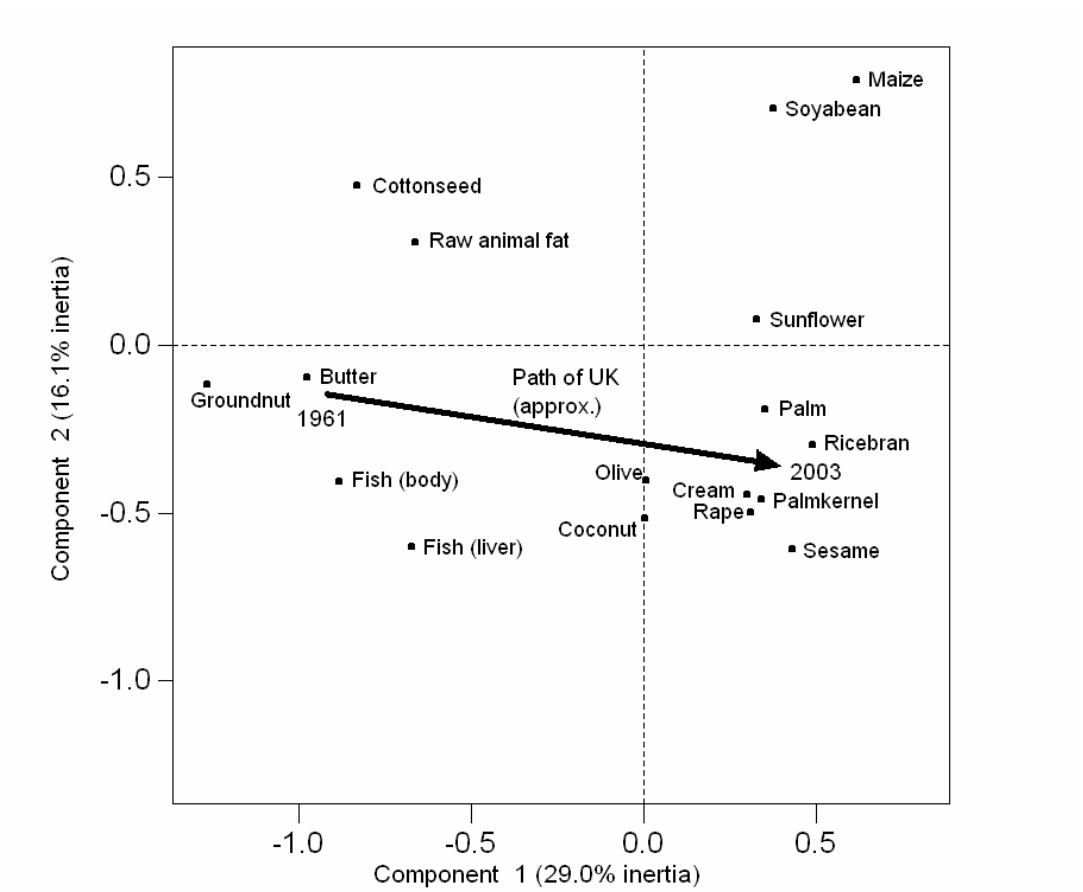
Figure 3a: Correspondence analysis – edible lipids plotted by their importation in different world regions in 1961 and